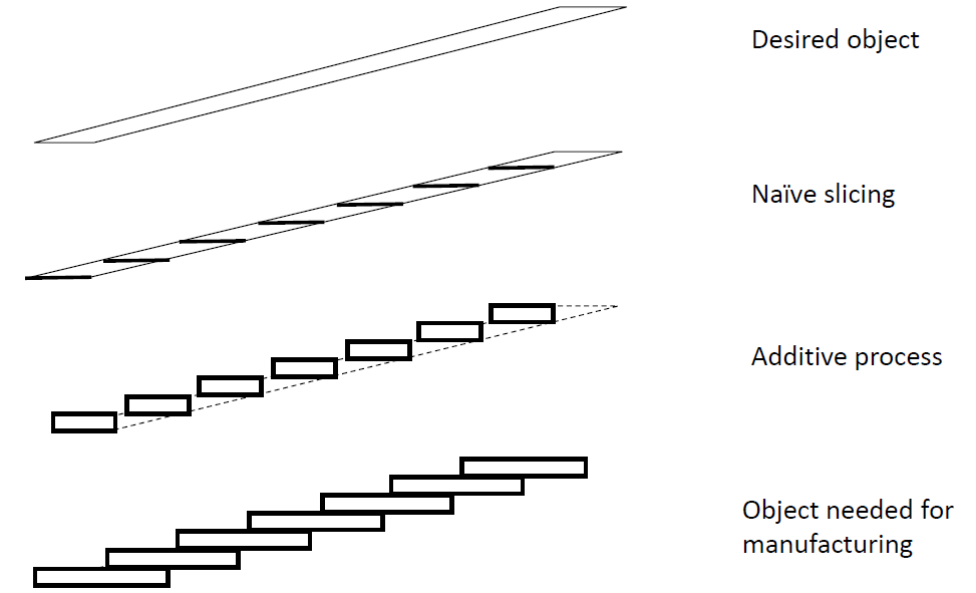
Figure 8. Slice generation on sloping